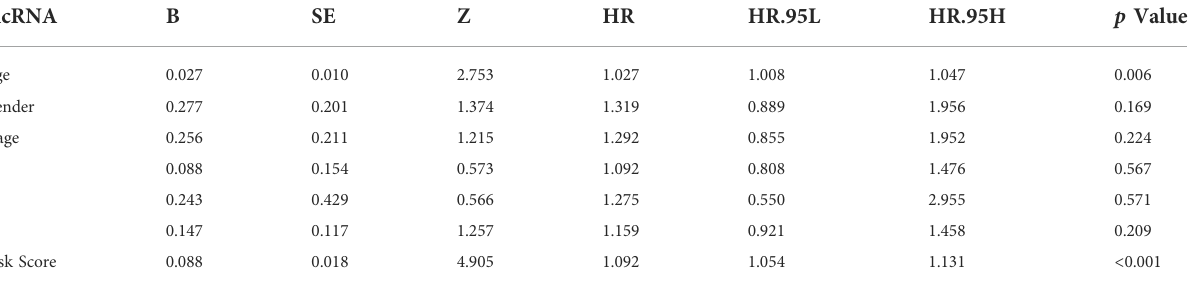
TABLE 2 Multivariate Cox regression based on clinical characteristics and risk scores in STAD. lncRNA